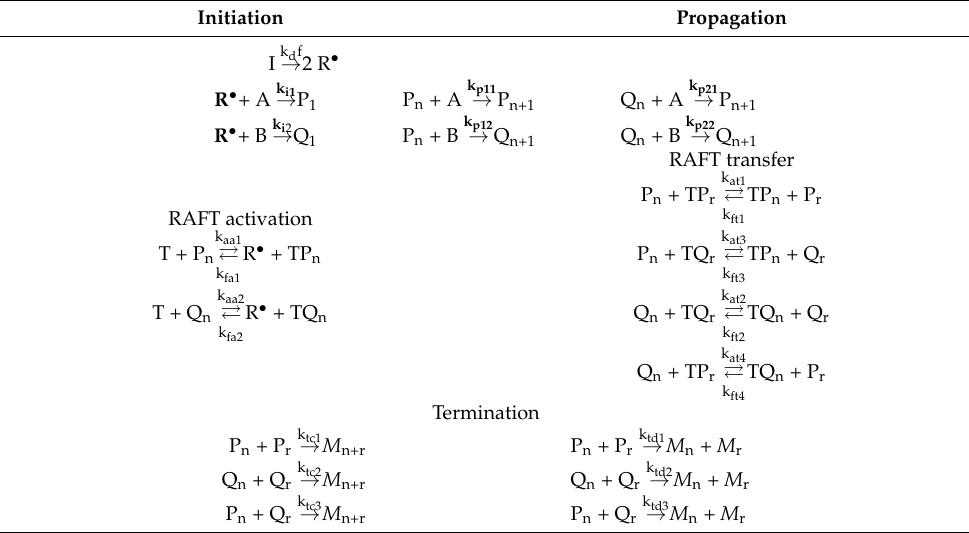
Table 1. Detailed polymerization scheme used in this study.